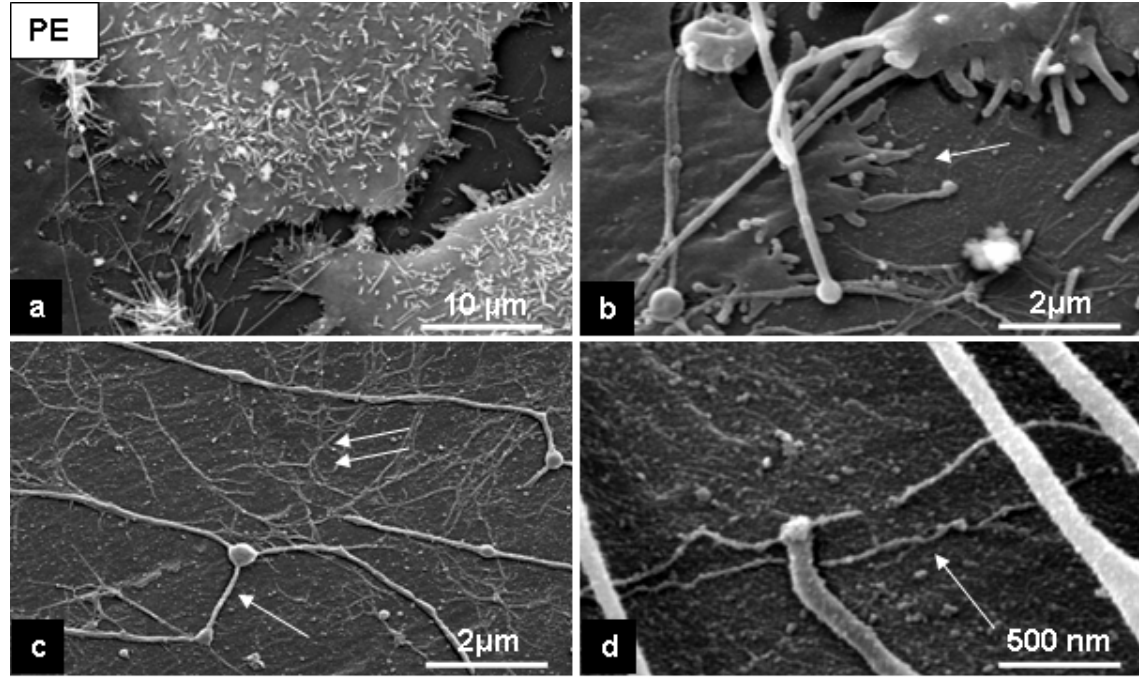
Figure 5. Representative SE-microscopic images of cell behavior on the PE-surface after 24 hours of cultivation. Note: a flattening of cells (a), cell filopodia by cell-substrate contacts (b, arrow), cell prints of motility (c, arrow) and a fine filaments network on the substrate (c, double arrows, d,